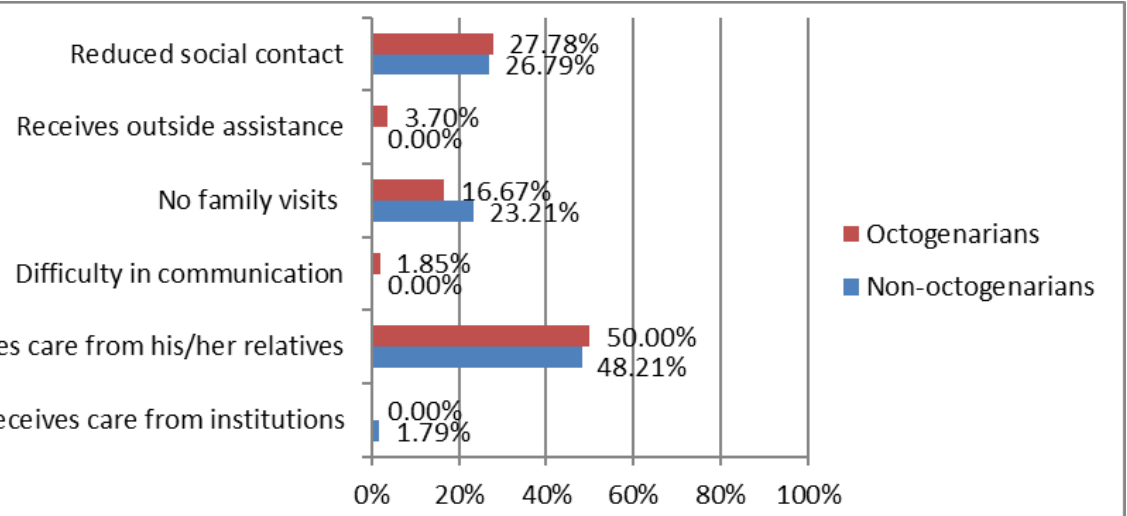
Figure 2. Differences between octogenarians vs. non-octogenarians in changes in social support during COVID- 19 confinement. Octogenarians (≥80 years; n = 53). Non-octogenarians (<80 years; n = 67).